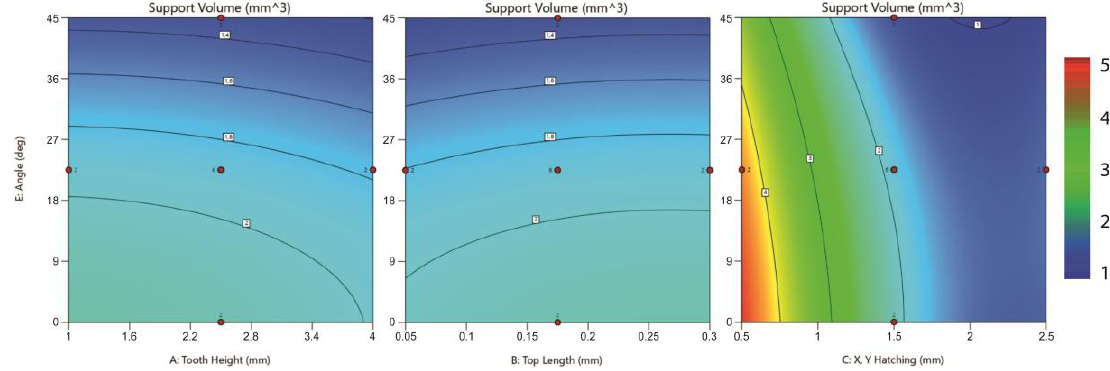
Figure 7. Contour plots of support parameters and Overhang Angle on Support Volume.